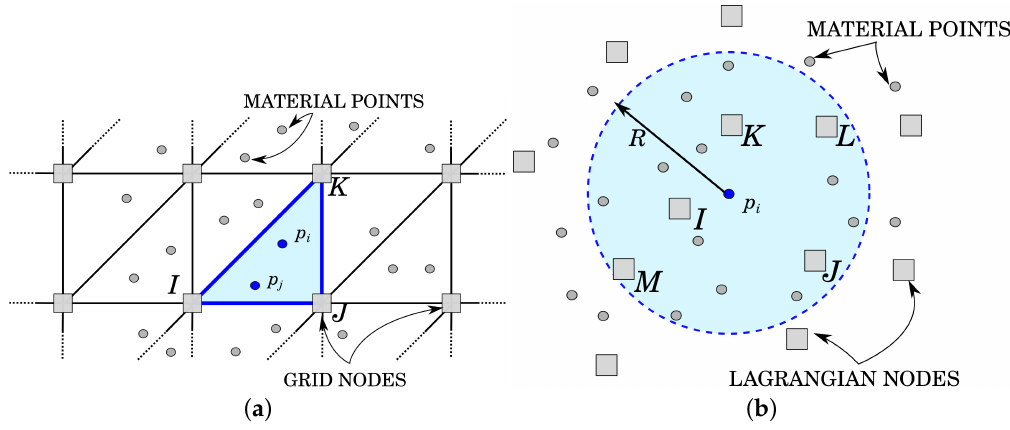
Figure 1. Shape functions calculation in MPM and Galerkin Meshfree Method (GMM). ( a ) MPM. The shape functions on the material point p i are evaluated using the FE shape function of element I-J-K; ( b ) GMM. The shape functions on the material point p i are evaluated using the information on the nodes sufficiently close to the material point